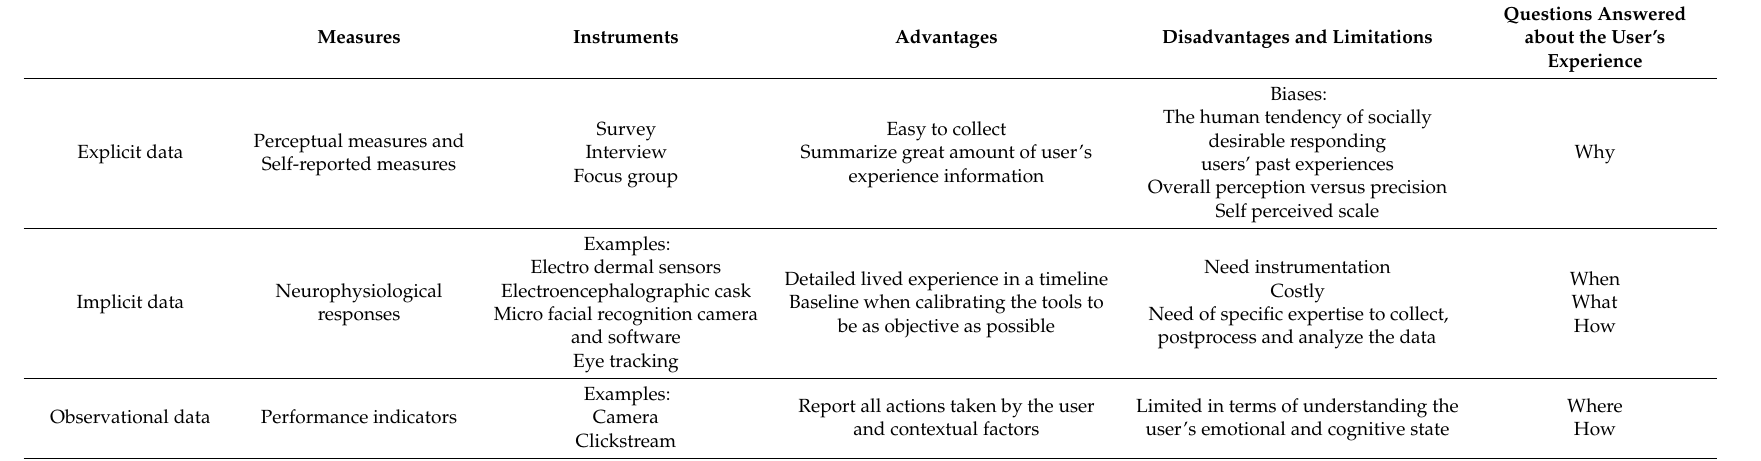
Table 1. Advantages and Limitations of data